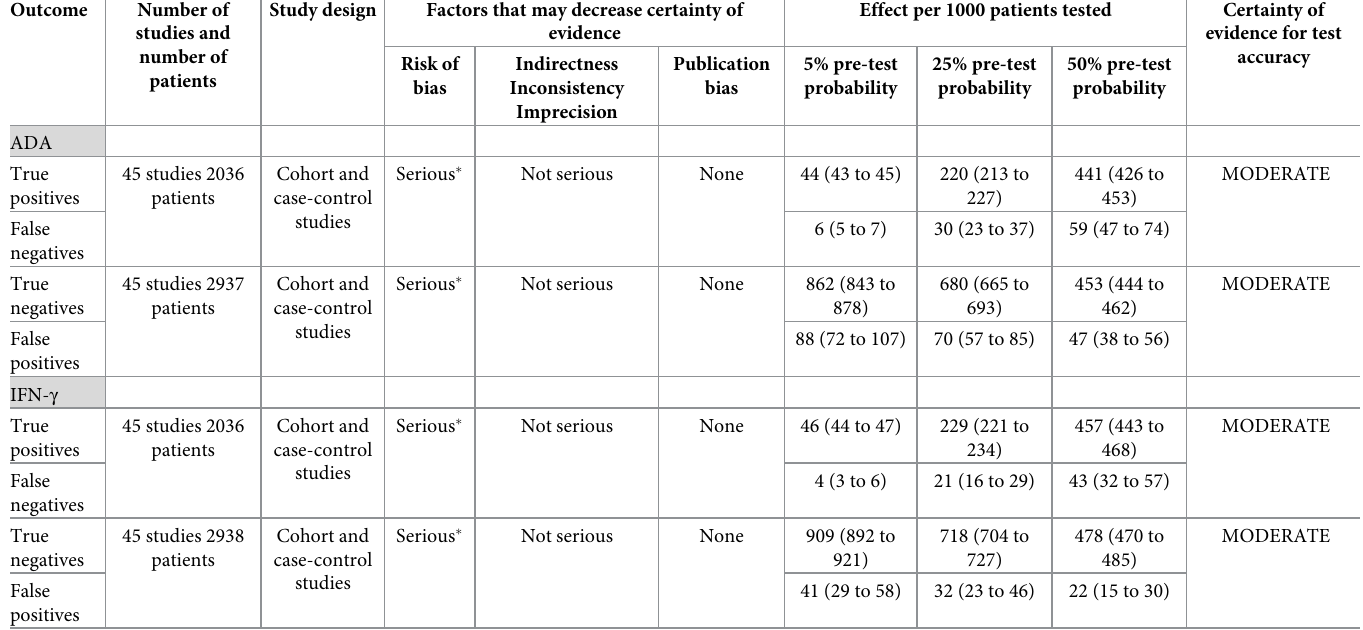
Table 2. Summary of findings from studies evaluating pleural fluid adenosine deaminase (ADA) and unstimulated pleural fluid interferon-gamma (IFN- γ ) for diagnosing pleural